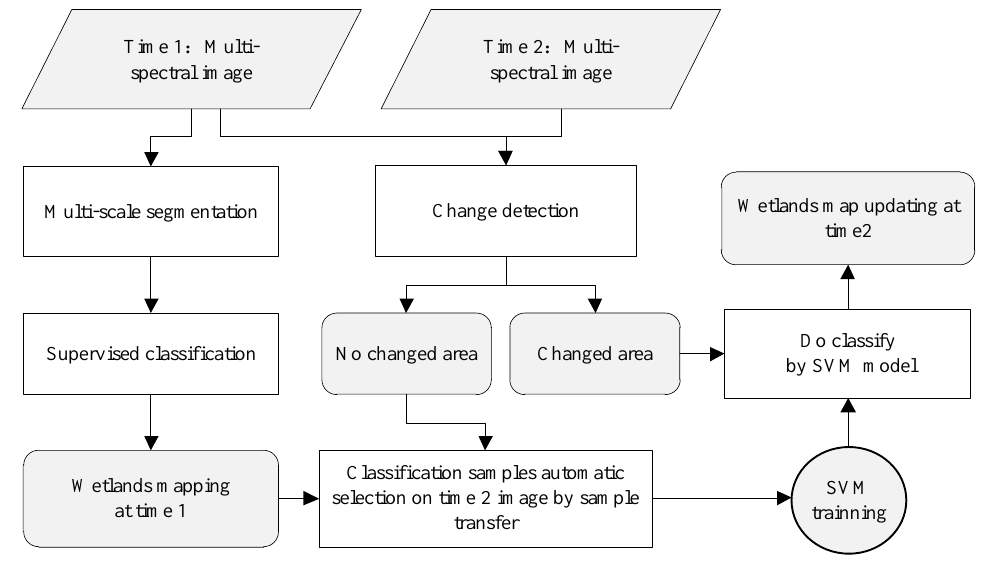
Figure 2. Diagram of wetland classification and updating process based on sample transfer learning.